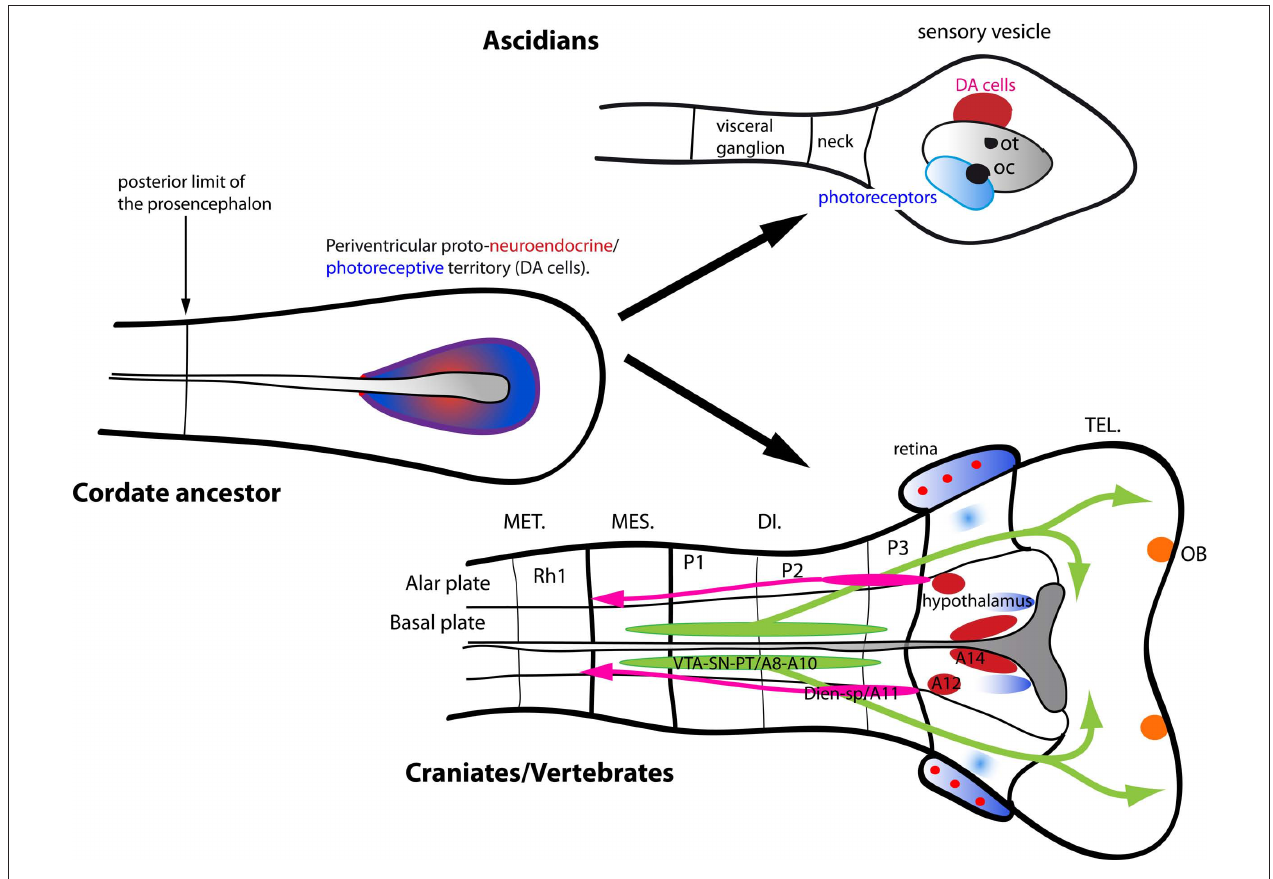
modulate the motor response to light. In craniates/vertebrates, the telencephalon has tremendously increased in size, and the optic vesicle becomes separated from the anterior hypothalamus by bulging out of the neural tube. Several “new” DA systems have been co-opted simultaneously, mostly in the mesencephalon and the basal plate three first prosomeres. These DA cells homologous to those of the SN/VTA project on the dorsal and ventral pallium, representing a major innovation of vertebrates, with strong adaptive properties. The retina comprised several cell types inherited from the protochordate ancestor, including at least photoreceptor cells, pigmented epithelium, and amacrine